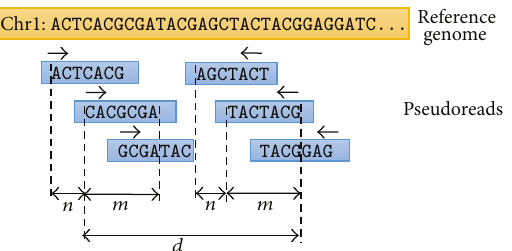
Figure 2: Generation of pseudoreads from the reference